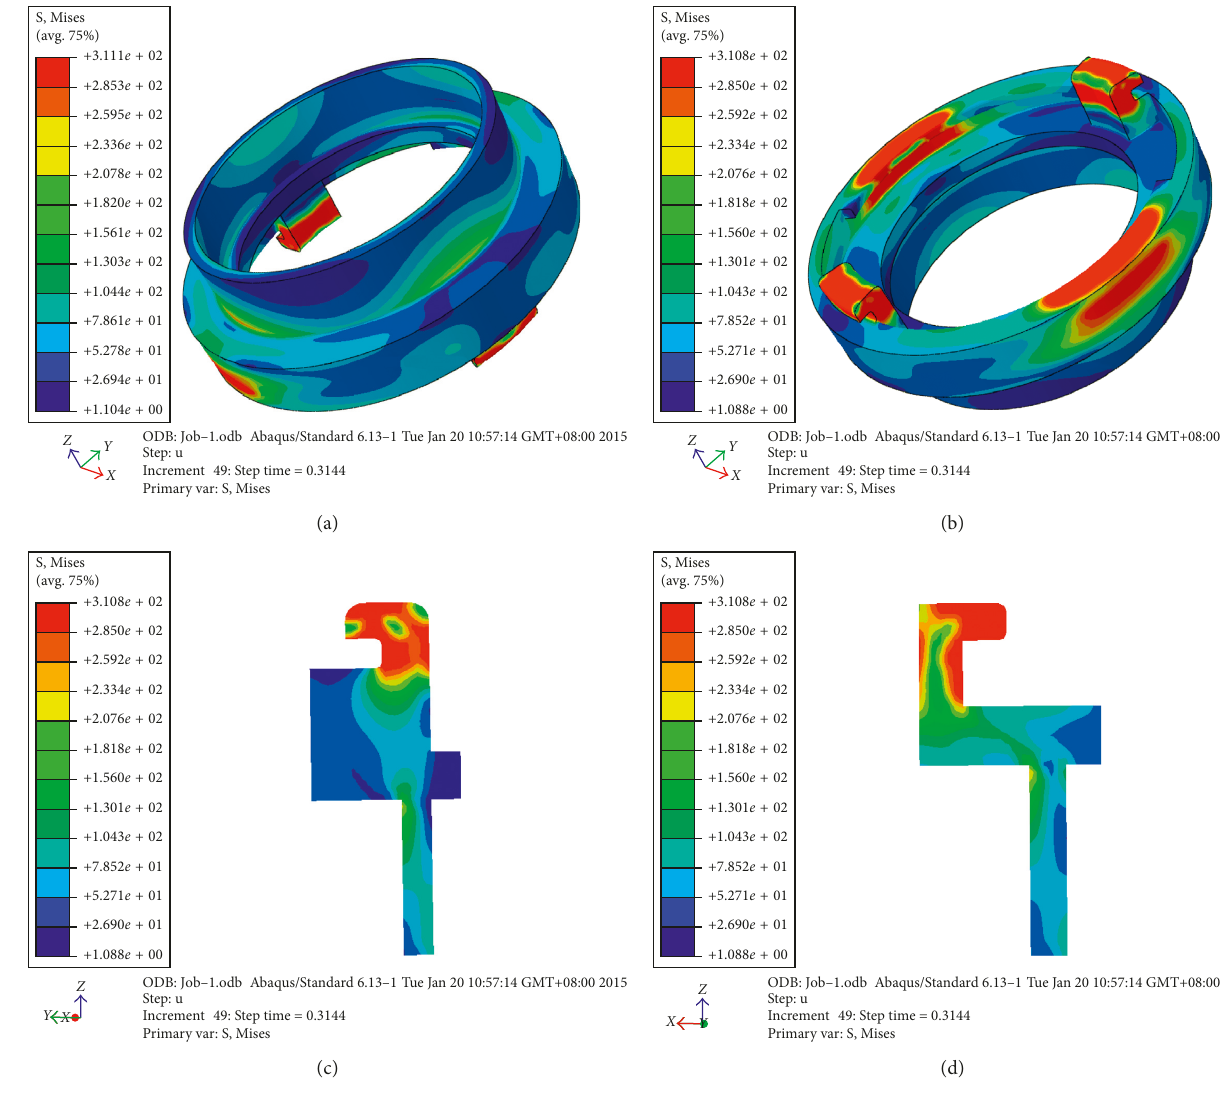
Figure 13: Stress distribution map of each part of the joint. (a) Stress distribution map of the fixed end. (b) Stress distribution map of the movable end. (c) Sectional stress distribution diagram of the wedge-shaped part of the joint. (d) Sectional stress distribution diagram of the joint